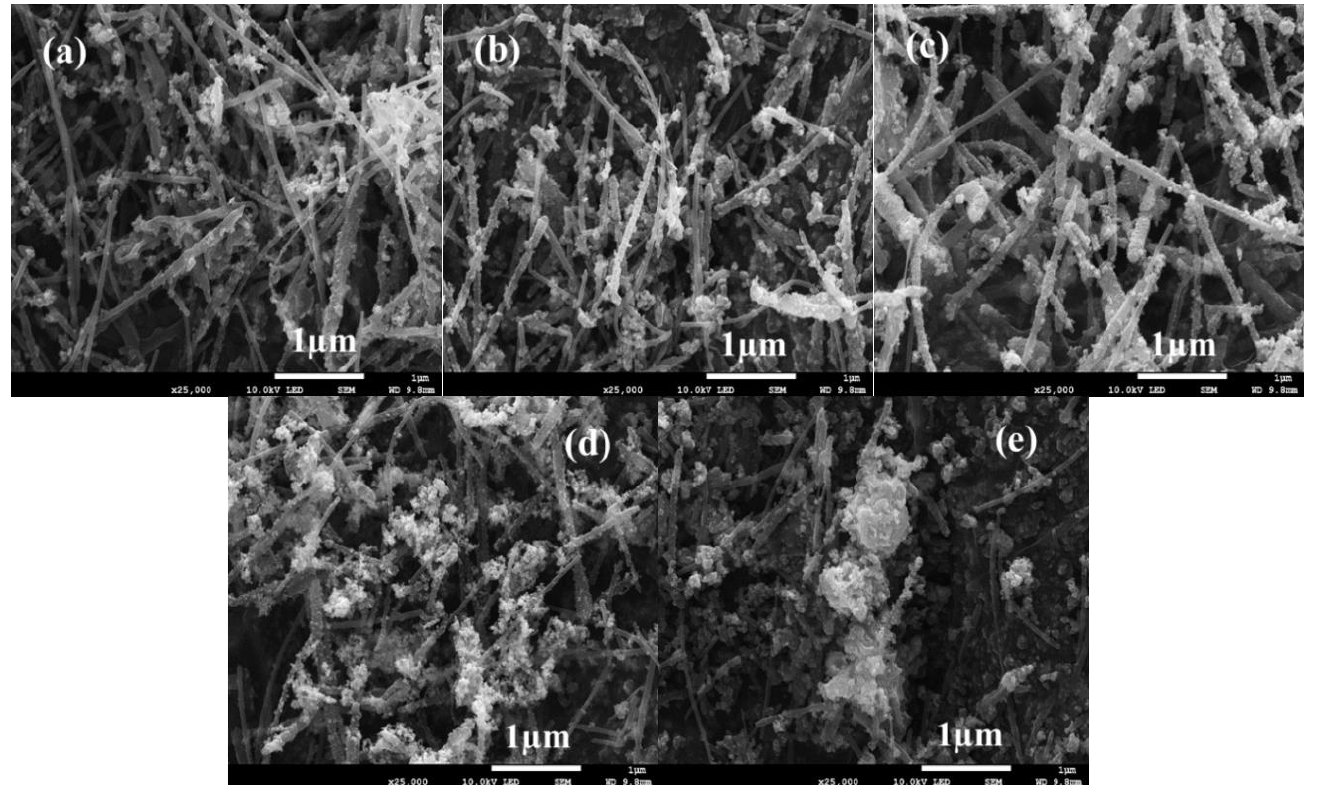
Figure 1. SEM images of C 35 /R y M electrodes with ( a ) 11, ( b ) 16, ( c ) 17, ( d ) 20 and ( e ) 23 wt% of Ru.